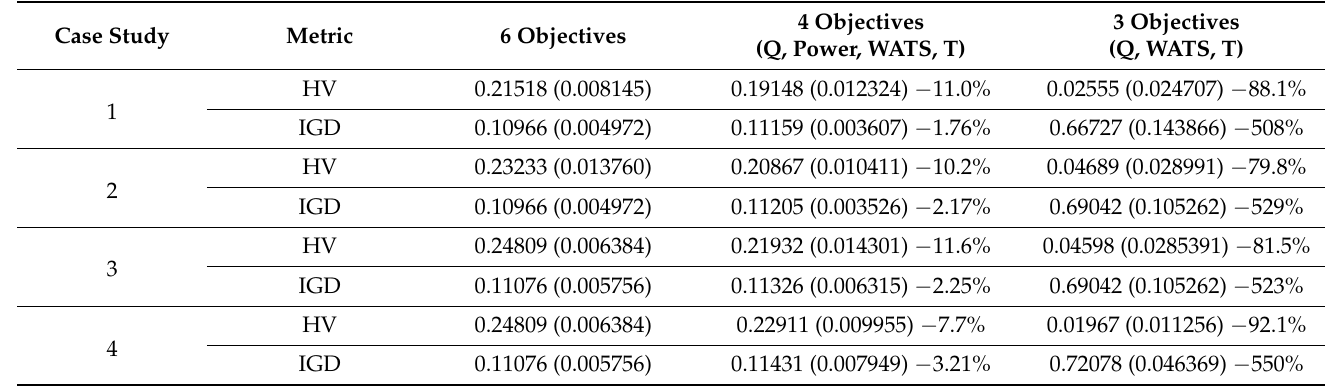
Table 7. Performance comparison using Hypervolume and IGD for the total number of objectives and the automatic reduction to four and three objectives (between brackets the standard deviation, and loss percentage relative to six objectives) for the four cases